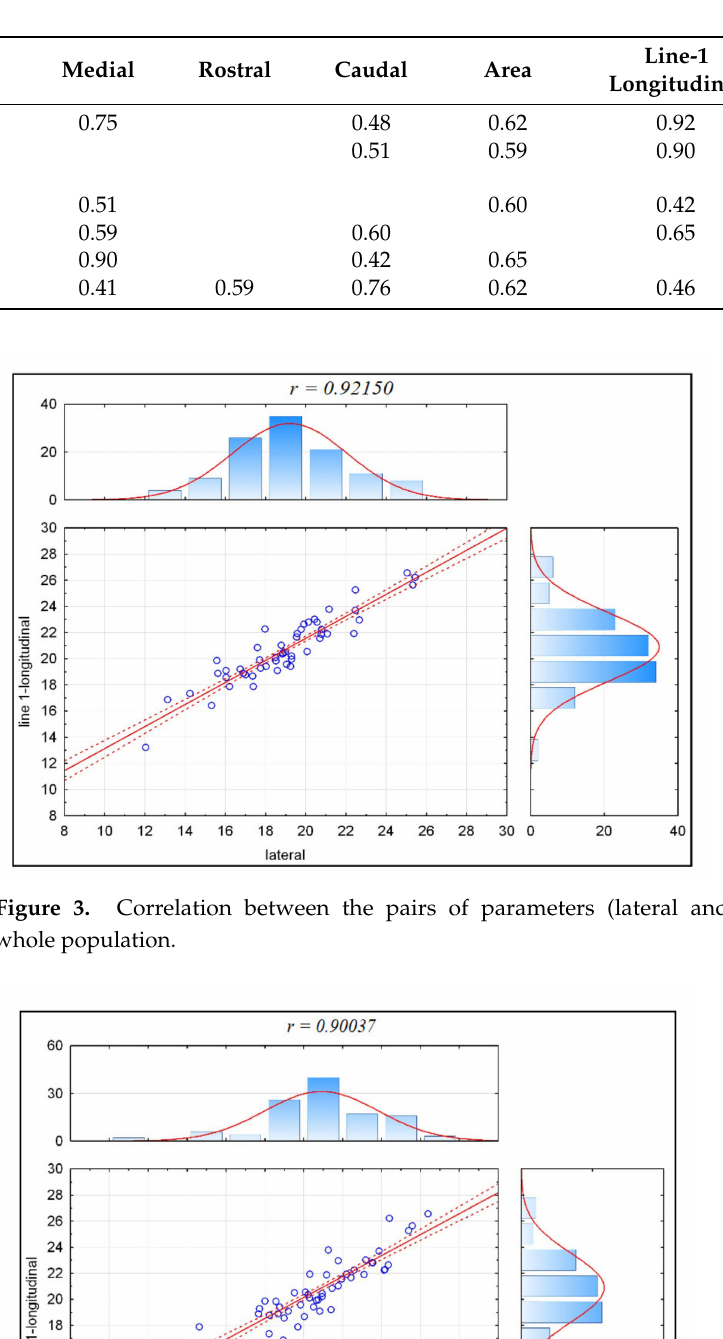
Table 2. The r -value for the whole population correlations ( r -value presented only for pairs showing statistically significant correlation, p ≤ 0.05).